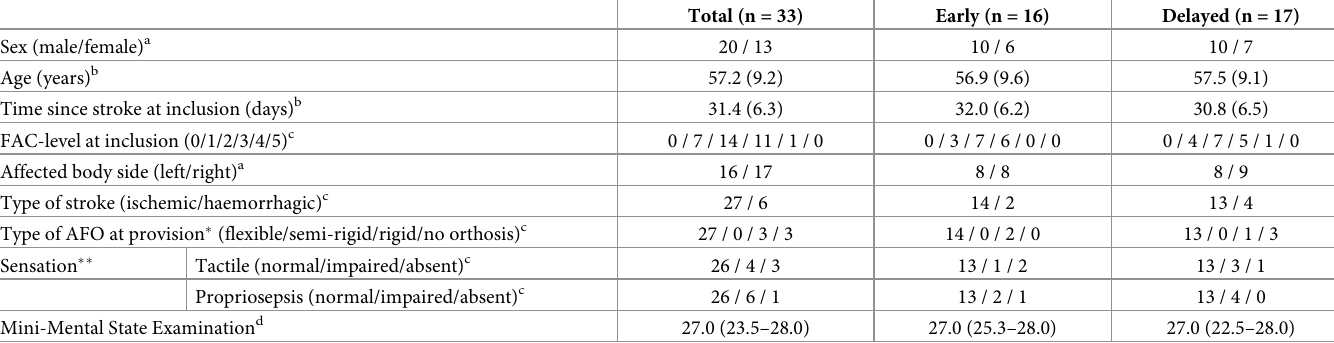
Table 2. Subject characteristics at